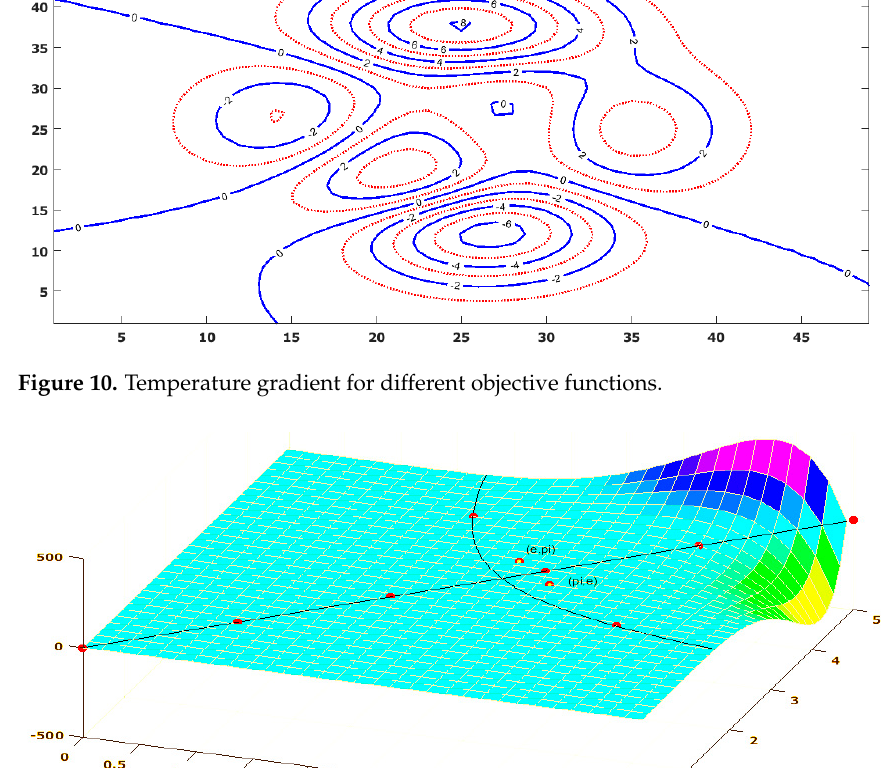
Figure 9. Dragonfly algorithm used for routing different ranges of temperature.